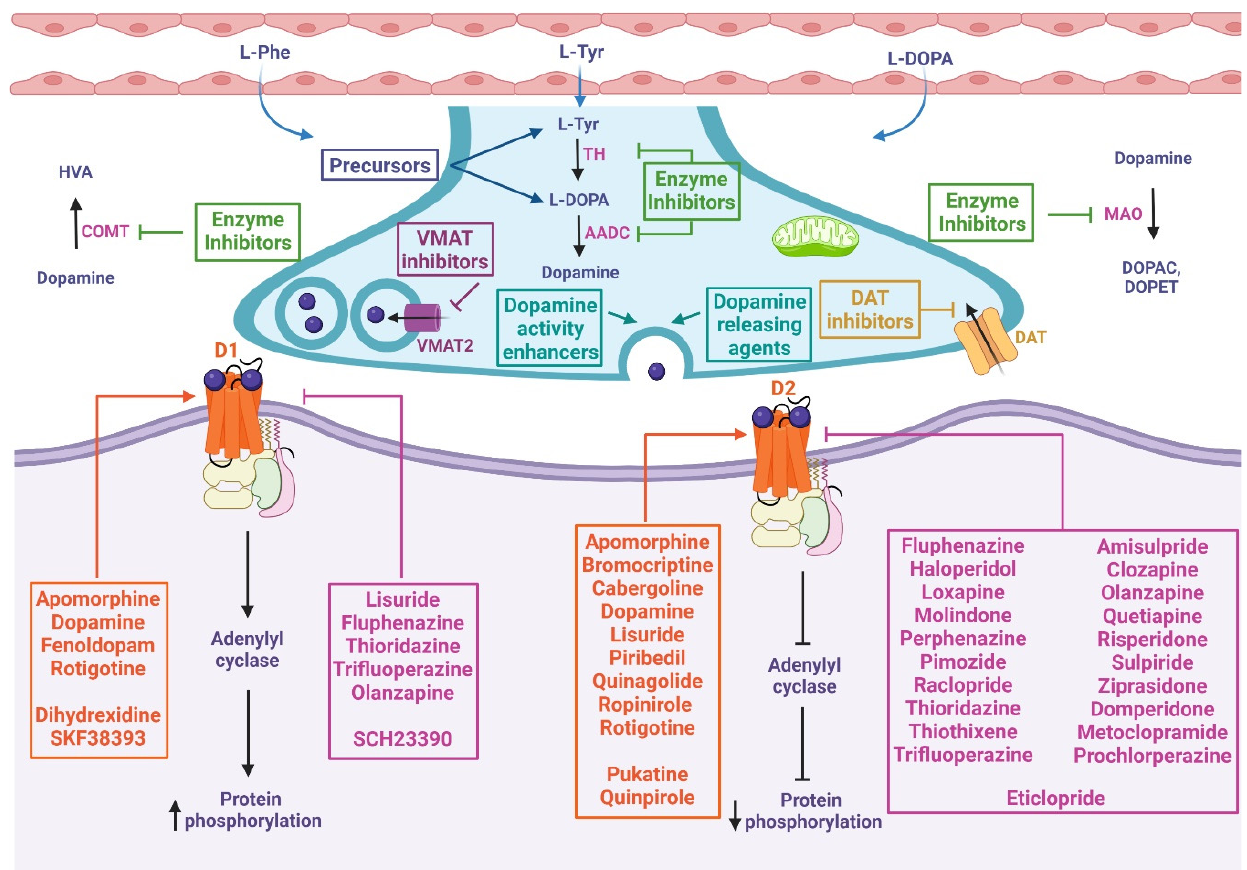
Figure 2. Mechanism of action of chemical compounds and drugs related to the dopaminergic sys- tem. These drugs can inhibit or activate diverse proteins involved in dopamine metabolism, includ- ing precursors, enzyme inhibitors, dopamine-releasing agents, dopamine reuptake inhibitors, do- pamine activity enhancers, and agonists or antagonists of D1-like and D2-like receptors. At presyn- apses : The precursors enable the biosynthesis of dopamine. VMAT inhibitors prevent the storage of monoamines in synaptic vesicles, resulting in the depletion of these neurotransmitters. DAT inhib- itors keep dopamine in the synaptic cleft longer by inhibiting its reuptake. Dopamine-releasing agents and dopamine activity enhancers increase the release of the activity of dopamine into the synaptic cleft. Dopamine synthesis inhibitors prevent the formation of dopamine as an endpoint. At postsynapses: The dopamine agonist (orange box) mimics endogenous dopamine function, thus activating or inhibiting adenylyl cyclase depending on whether it binds to D1-like or D2-like recep- tors, respectively. Dopamine antagonists (pink box) bind to but do not activate dopamine receptors, thereby blocking the actions of dopamine. L-Phe: L-phenylalanine, L-Tyr: L-tyrosine, TH: tyrosine